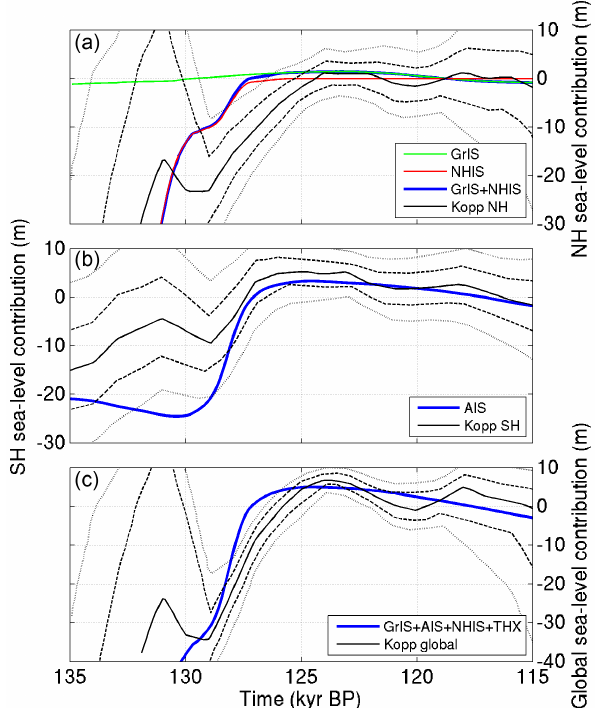
Figure 12. Modelled sea-level contributions from this study (colour lines) compared to probabilistic sea-level reconstructions (black lines) from Kopp et al. (2009) for the NH (a) , the SH (b) , and glob- ally (c) . For the reconstructions, solid lines correspond to the me- dian projection, dashed lines to the 16th and 84th percentiles, and dotted lines to the 2.5th and 97.5th